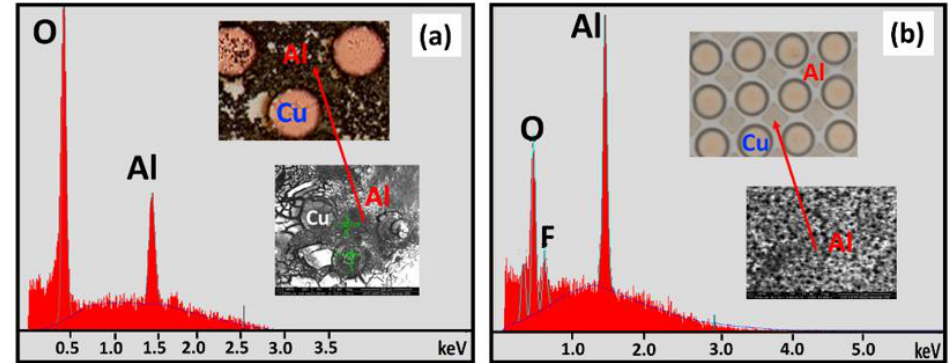
Figure 8. EDS analysis spectrum of corroded Cu microdot samples on Al after 44 h of immersion in ( a ) 5 ppm Cl − , pH 5, and ( b ) 5 ppm F − , pH 5 (inset: SEM and microscope image of the corroded samples).